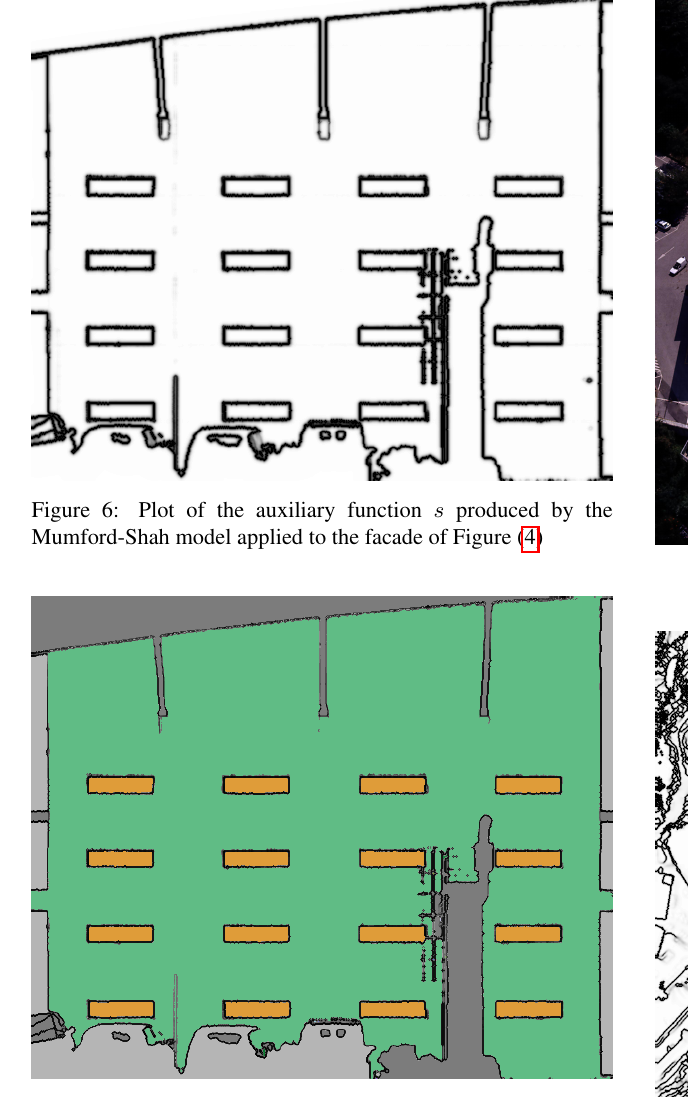
Figure 9: Plot of the auxiliary function s given by the Mumford- Shah model applied to the